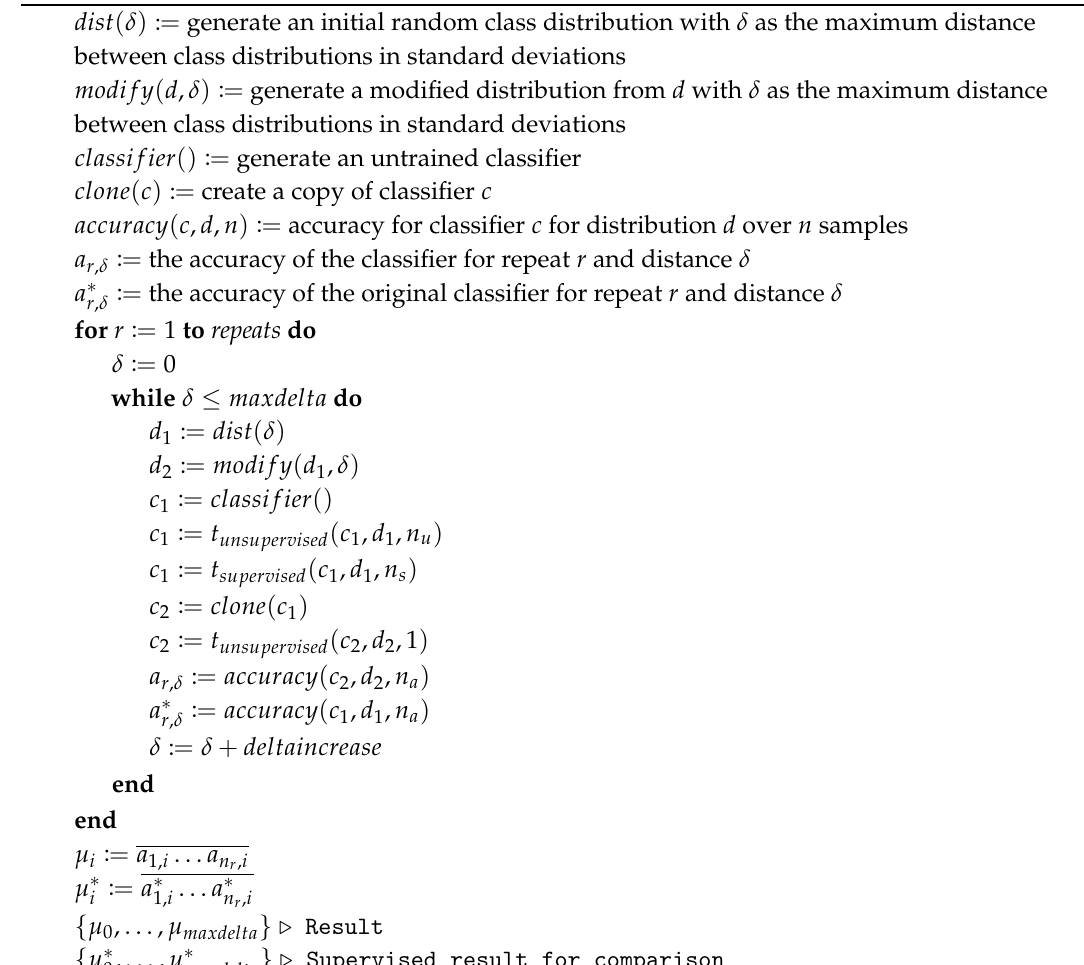
Algorithm 4: Procedure used for the simulation of QUEST to evaluate the effect of increasing the distance between class